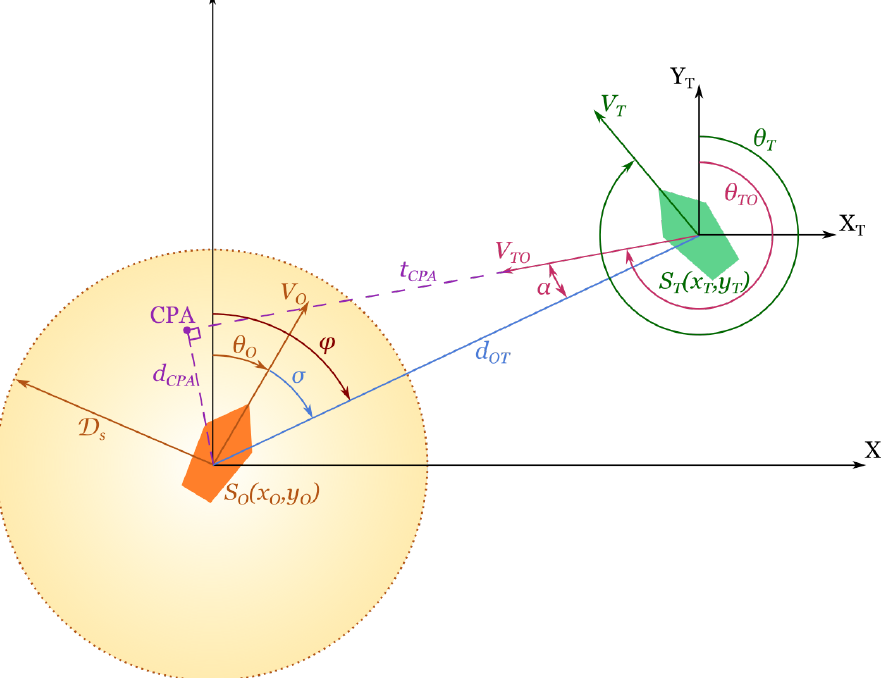
Figure 3. Geometric relation and motion parameters of two interacting ships—own ship (orange) and target ship (green). Idea adapted from Chen et al.